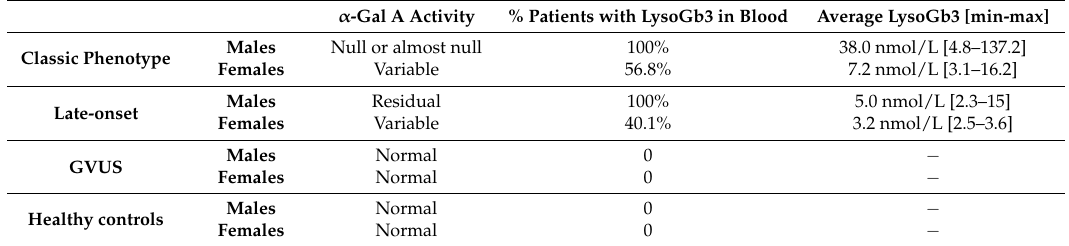
Table 5. Enzyme activity and blood accumulation of LysoGb3 in 471 patients studied. α -Gal A Activity % Patients with LysoGb3 in